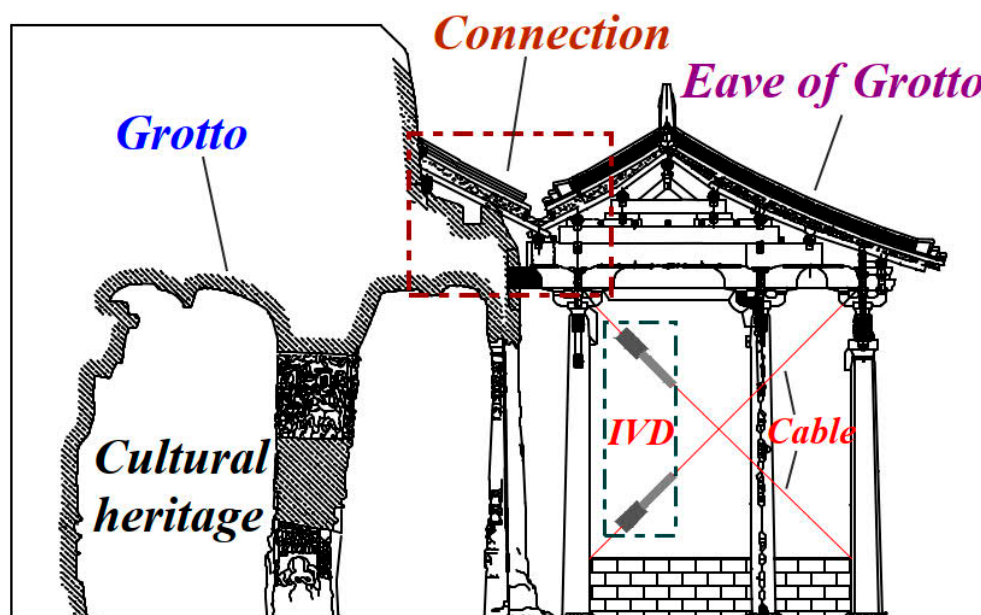
Figure 4. Layout of CIVD in eave–grotto system.